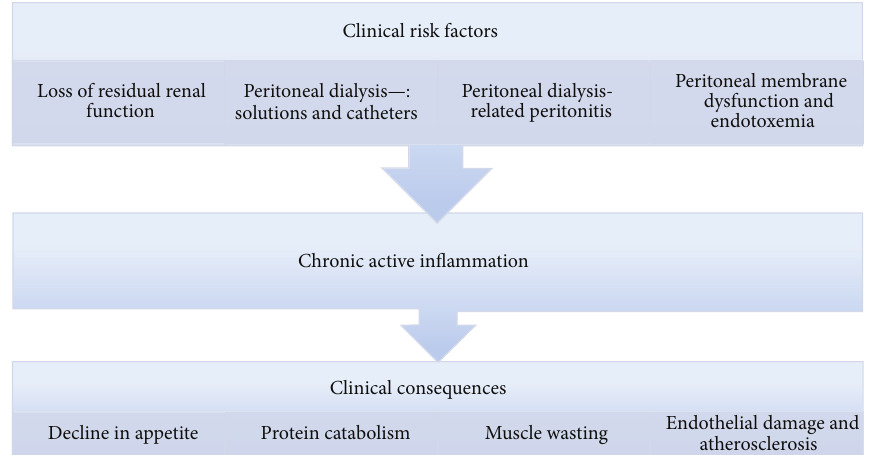
Figure 1: Flow diagram demonstrating clinical risk factors of inflammation in peritoneal dialysis patients leading to chronic active inflammation and clinical